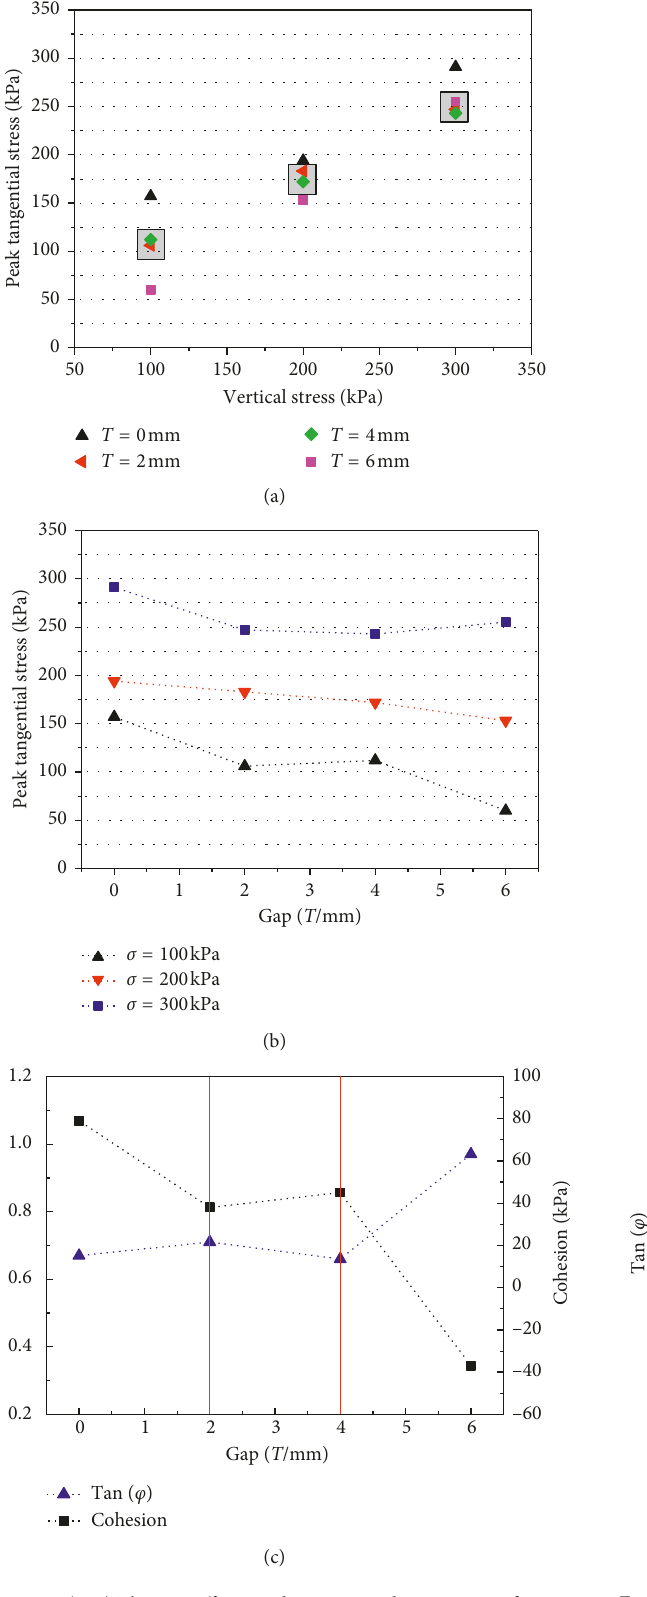
Figure 6: (a–c) The gap effect on the tangential properties of S-RM (shear box, L � 300mm, W � 300mm, and H �